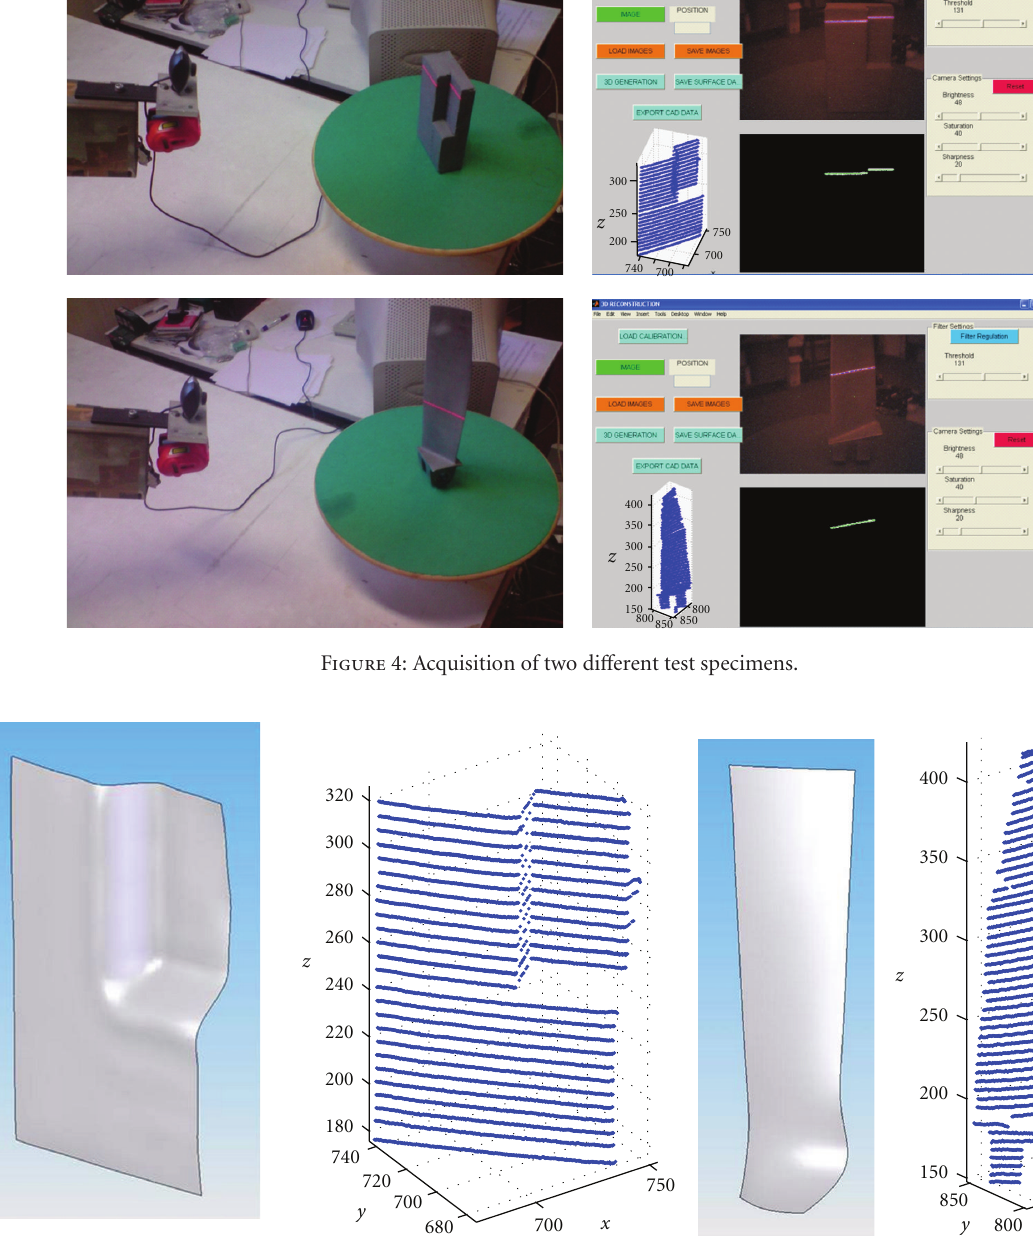
of processing performed with the CAD software, for two di ff erent test